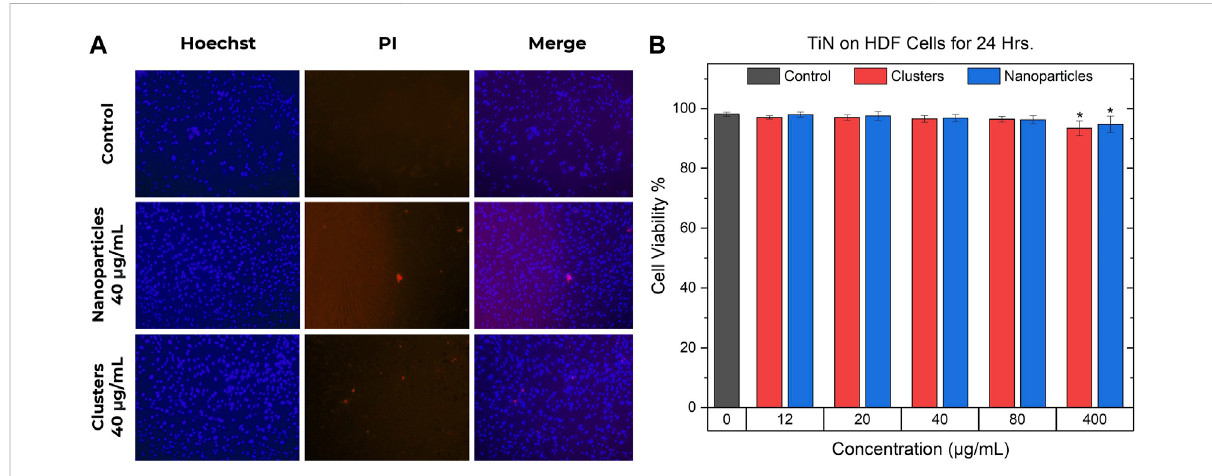
FIGURE 7 TiNnanoparticlesandclusterscellviability. (A) HoechstandPIdoublestaininginHDFcells.Theimagesintheleftcolumnshowthecellsstained with Hoechst, the middle column images show the cells with positive staining of PI, and the right column shows the merged images. The fi rst row shows a control group of cells, the second shows a concentration of 40 μ g/mL of TiN NPs treatment, and the last row shows a concentration of